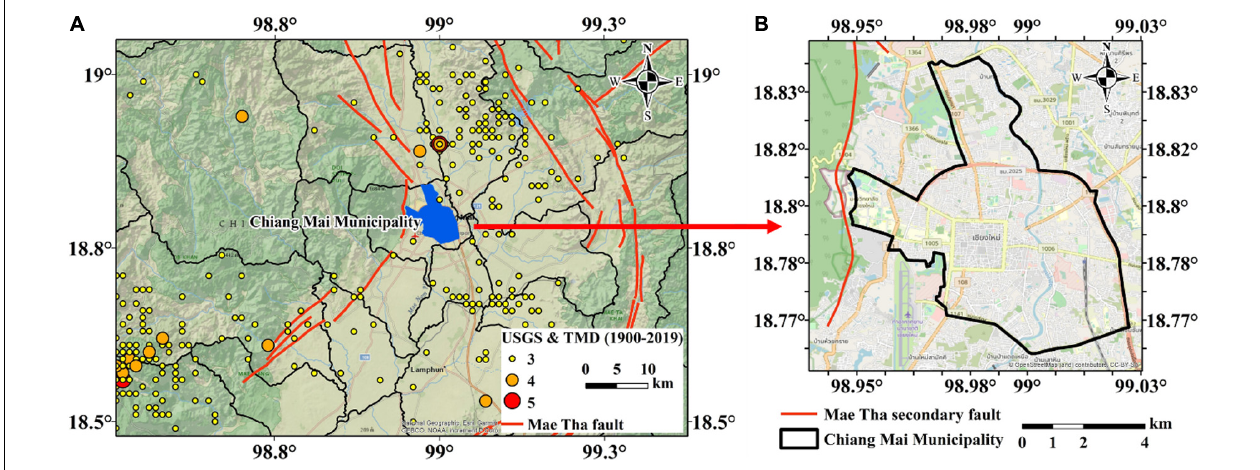
FIGURE 2 | The study area of Chiang Mai Municipality with past earthquake records. (A) Location of the study area and Mae Tha fault zone; (B) enlarged study area.